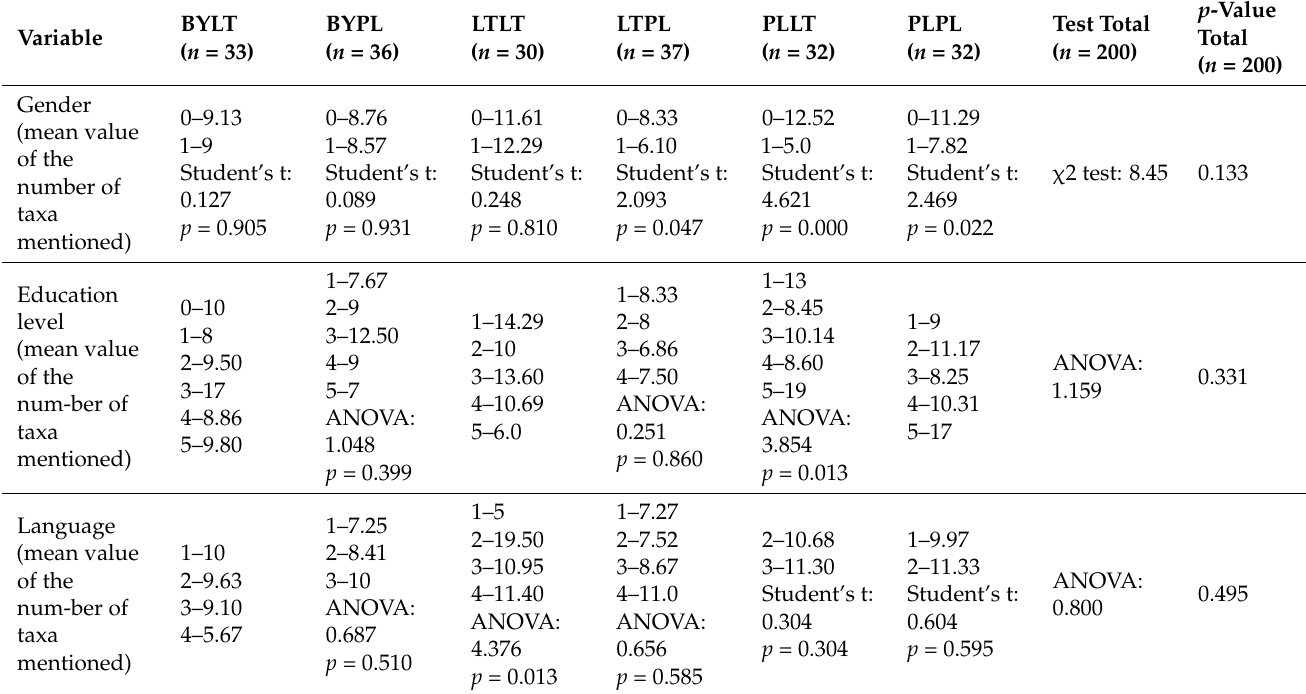
Table 3. Influence of socio-demographic variables on the number of taxa mentioned by interview- ees.